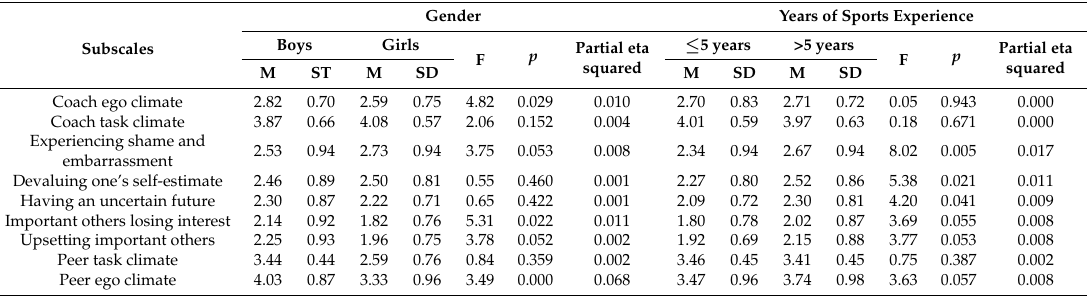
Table 2. Multivariate analysis (intersubject effects according to gender and years of sports experience) based on the subscales of PMCSQ-2, PFAI, and PeerMCYSQ.